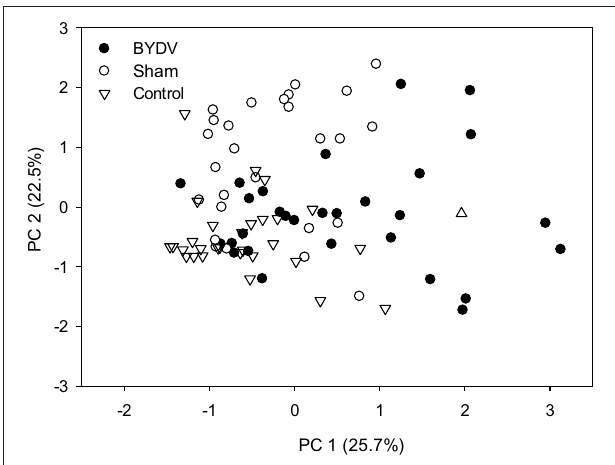
FIGURE 3 | Principal components analysis comparing the multivariate structure in concentrations (mg/g) of five phytohormones: abscisic acid, jasmonic acid, methyl jasmonate, methyl salicylate, and salicylic acid due to the effect of three virus infection treatments (BYDV, sham treatment, and nondamaged